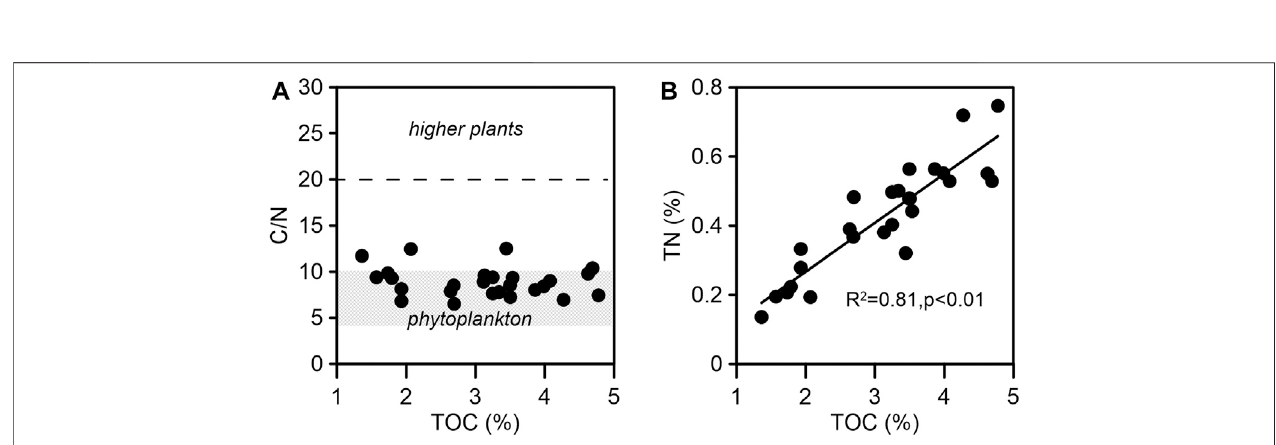
FIGURE 4 | (A) Plot between C/N and TOC. Typical C/N ratio ranges for higher plants and phytoplankton referred to the study by Hedges and Oades. (1997) and Talbot and Lærdal. (2000) were labeled. (B) Relationship between total nitrogen (TN) and TOC.